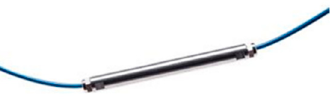
Figure 2. Temperature sensor.